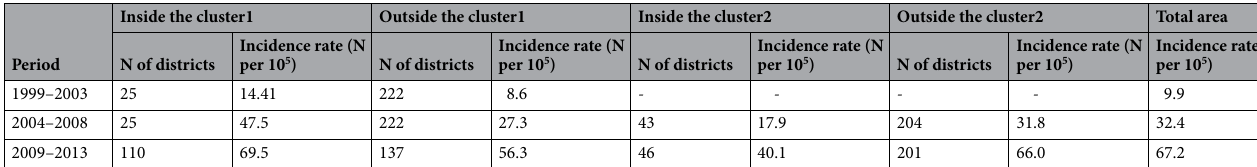
Table 1. Age-standardized incidence rates of thyroid cancer inside and outside the spatial clusters during 1999–2003, 2004–2008 and 2009–2013 in Korea. N number.